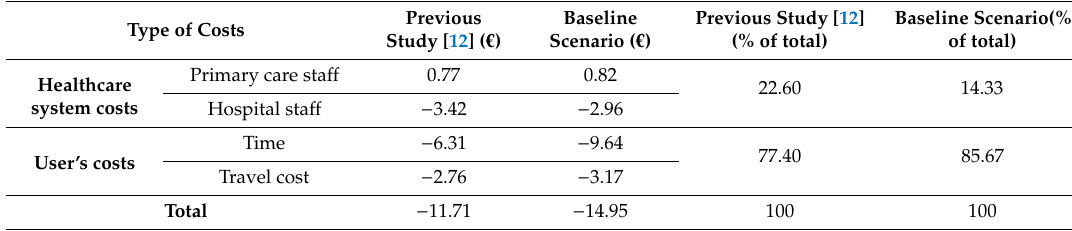
Table 6. Di ff erential costs per visit. Comparison between